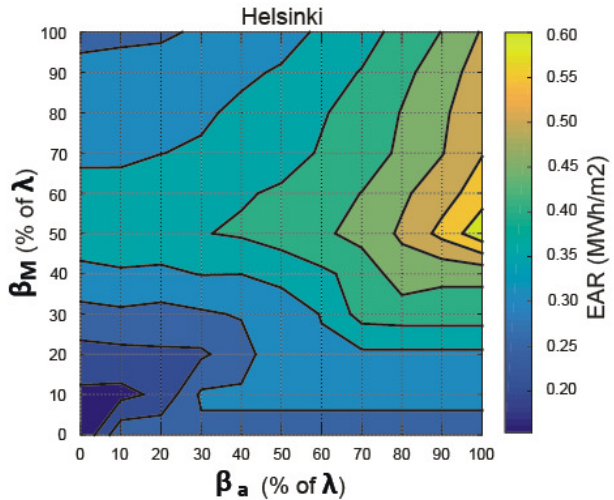
Figure 11. EAR in